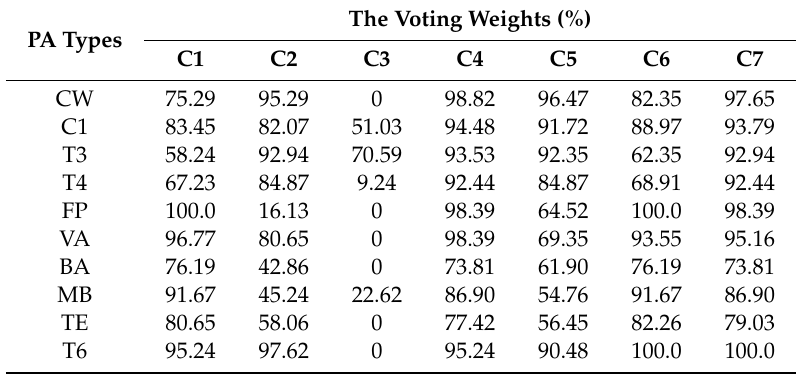
Table 3. The voting weights setting of di ff erent sensor classifiers for di ff erent PA types.